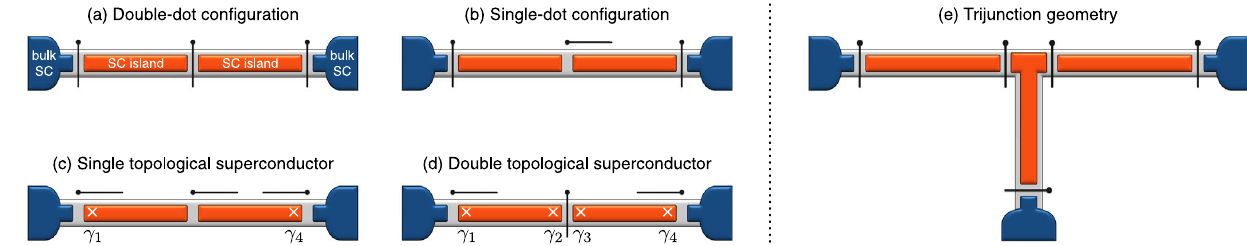
FIG. 3. Geometries utilized for the proposed milestone experiments. (a) – (d) Two-island setup with gate-tunable valves that electrically tune the Josephson-to-charging-energy ratios for each pair of adjacent superconducting regions. Various interesting regimes are possible depending on the valve configurations: When cut off from the outer bulk superconductors, the islands can (a) form independent double quantum dots or (b) effectively combine into a single dot. Restoring the connection to the outer superconductors quenches charging energy and generates topological superconductivity on the islands. Either two or four Majorana zero modes (denoted by × ’ s) appear depending on the middle-valve configuration as shown in (c) and (d). (e) Trijunction geometry that enables braiding through similar valve